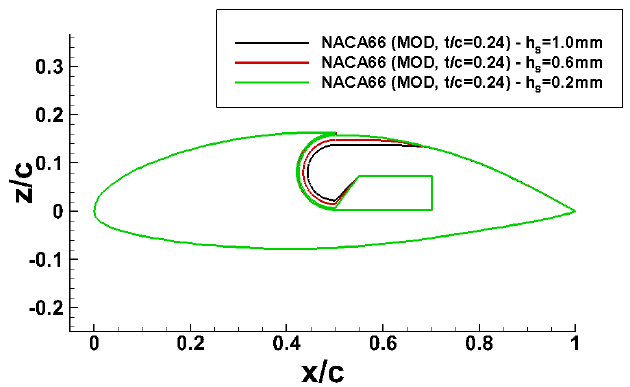
Table 5. Computation conditions according to the slit height.